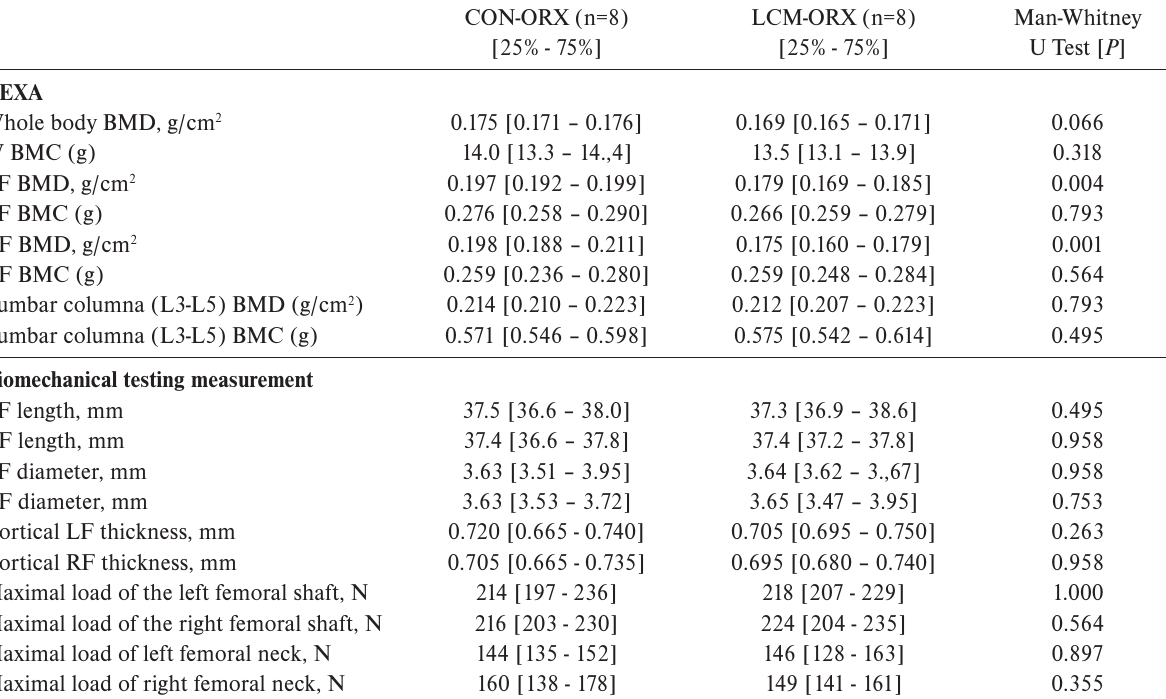
Table 3. Comparison of values from DXA analysis and values of biomechanical